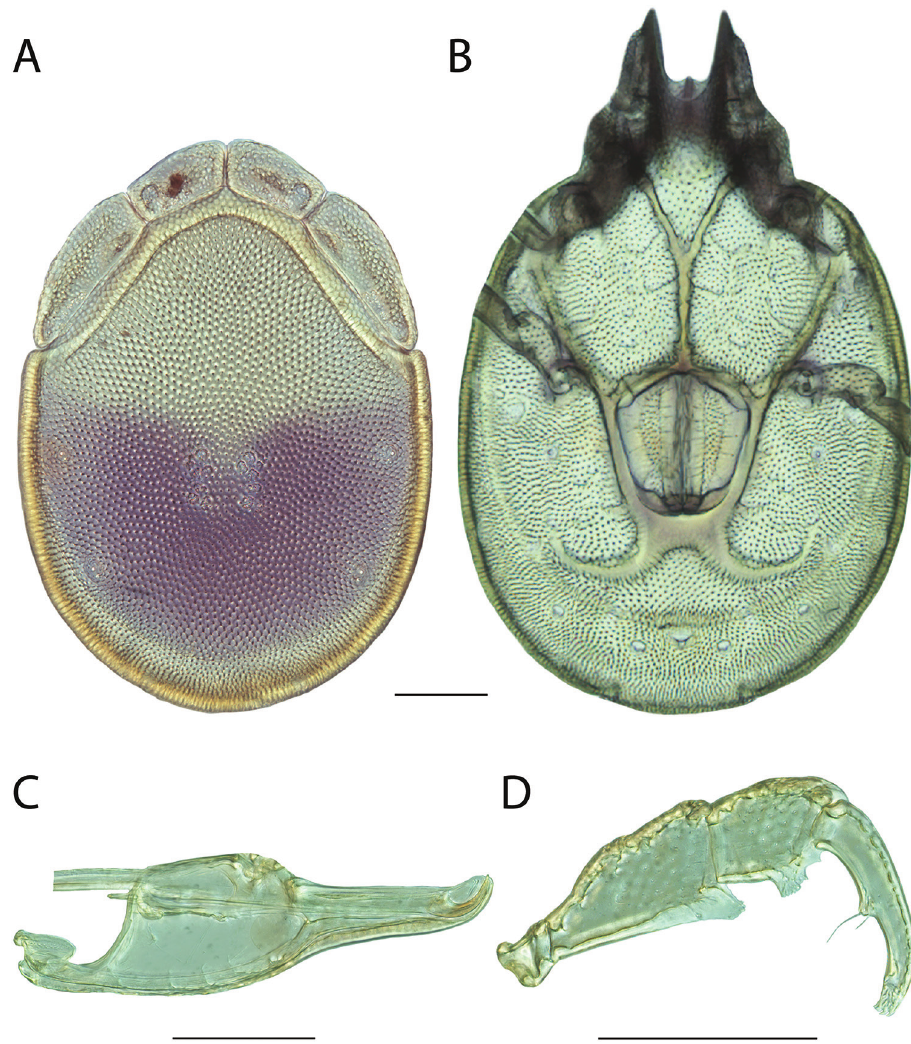
Figure 250. Torrenticola tahoei female: A dorsal plates B venter (legs removed) C subcapitulum D pedipalp (setae not accurately depicted). Scale = 100